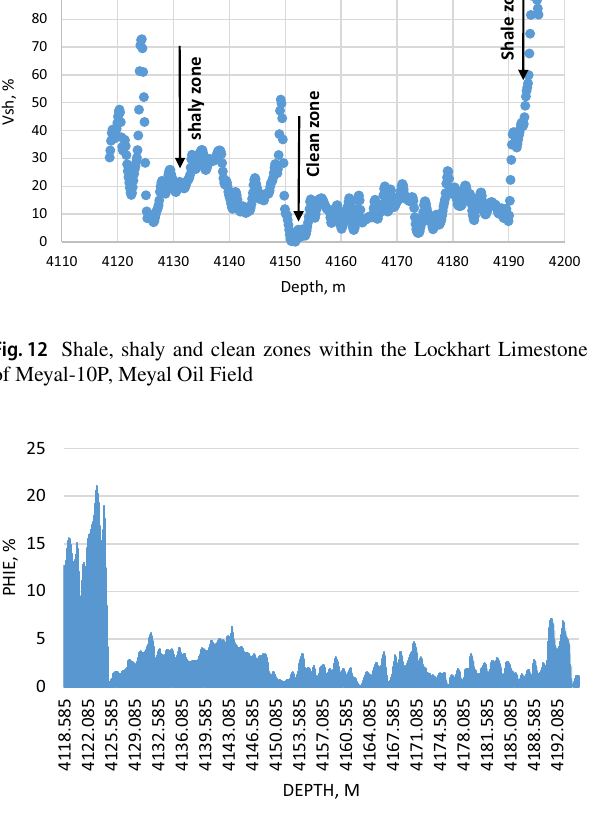
Fig. 13 Effective porosity versus depth of the Lockhart Limestone of Meyal-10P, Meyal Oil